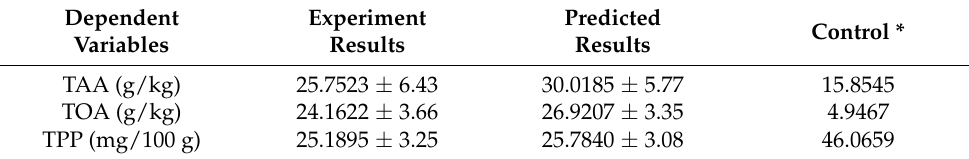
Table 7. The results of bee pollen extracts obtained under optimal and control